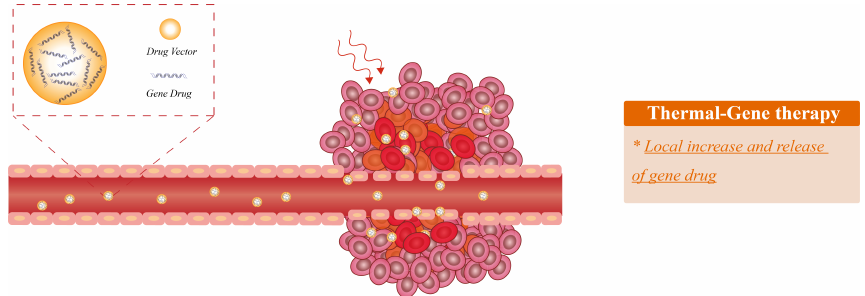
Figure 5. The mechanism of synergetic thermal therapy and gene therapy. Thermal therapy improves cell membrane permeability to increase the efficiency of gene transfer, achieving local increase and release of gene